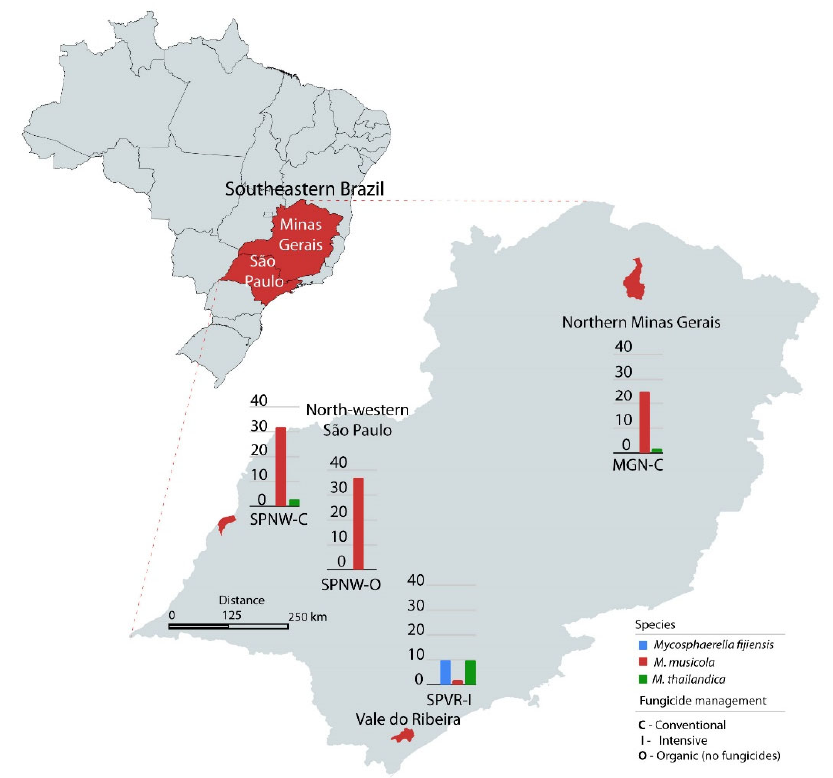
Figure 1. Population sampling of the black leaf streak ( Mycosphaerella fijiensis ), yellow Sigatoka ( M. musicola ), and leaf spot ( M. thailandica ) pathogens from banana plantations with contrasting fungicide management in Southeastern Brazil during the 2020/21 cropping season a . a States and counties were colored in red: Ilha Solteira county, from Northwestern Sâo Paulo state (SP), Jacupiranga, Registro and Sete Barras counties from Vale do Ribeira (SP), and from Janaúba county, from Minas Gerais State (MG). In addition to M. fijiensis and M. musicola , the species M. thailandica was a prevalent co-inhabitant with the black leaf streak and yellow Sigatoka pathogens in three of the populations sampled.